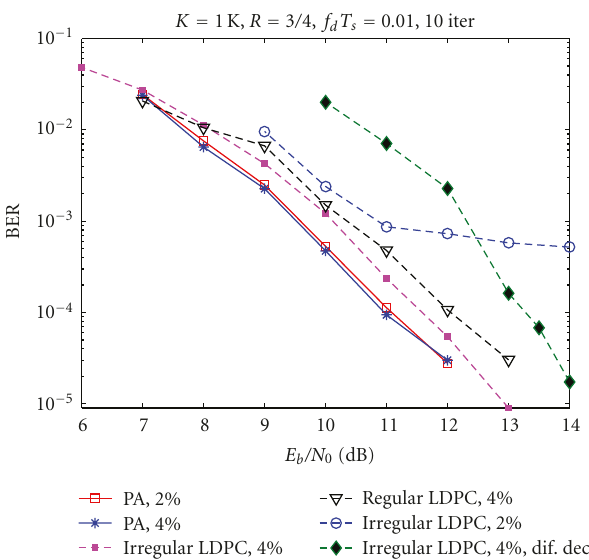
Figure 2: Comparison of PA codes and LDPC codes on fast-fading Rayleigh channels with noncoherent detection and decoding. Solid line: PA codes, dashed lines: LDPC codes. Code rate 0.75, data block size 1 K, filter length 65, normalized Doppler spread 0.01, 10 global iterations, and 4 (local) iterations within LDPC codes or the outer code of PA codes inside each global